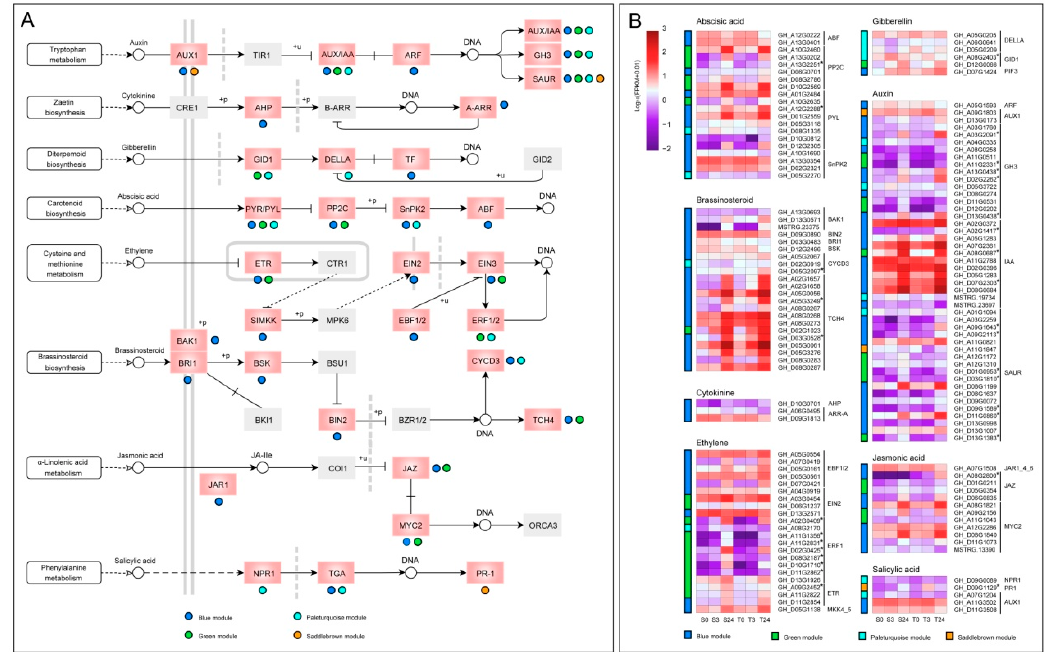
Figure 10. The DEGs of four significant modules in the plant hormone signaling pathway. ( A ) Distribution of genes from four modules on eight plant hormone pathways. The pink boxes denoted the genes enriched, and the colored dots below or to the right of the pink boxes indicated from which module the genes came. The gray boxes denoted the genes that had not been enriched. The meanings of different types of arrows have been strictly defined in KEGG databases (https://www.genome.jp/kegg/document/help_pathway.html). ( B ) The expression patterns of genes distributed on the eight hormone signaling pathways in the four modules. Gene expression data were normalized by log 10 (FPKM + 0.01). The colored bar on the left of each heatmap represented the modules from which the corresponding genes on the right come from.